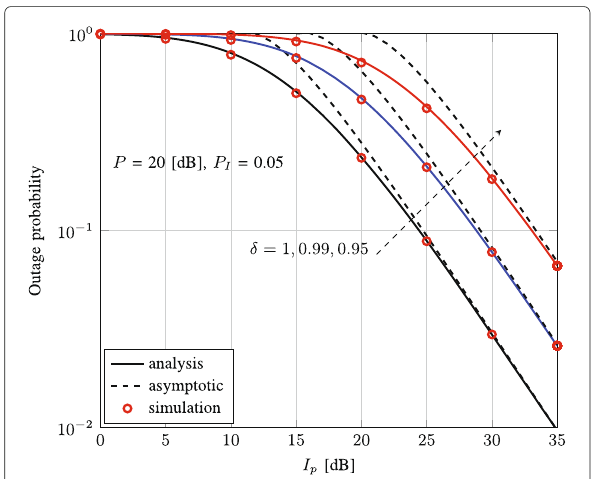
Fig. 3 Effect of the correlation coefficient on the secondary system outage performance